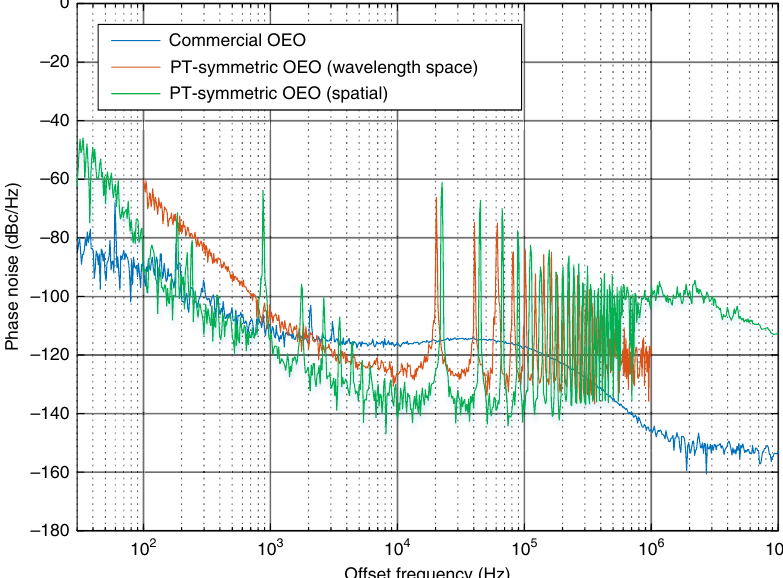
Fig. 5 Measured phase noise of the generated microwave signal (red). For comparison, the phase noises of microwave signals generated by a commercial microwave source (blue) and a spatially separated dual-loop OEO with a 9.1-km loop length (green) are also